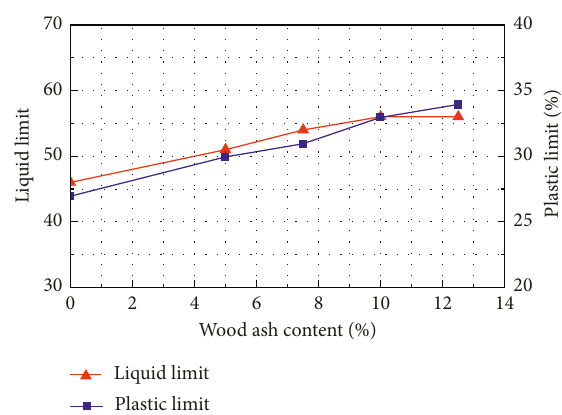
Figure 2: Variation of LL and PL with wood ash content.